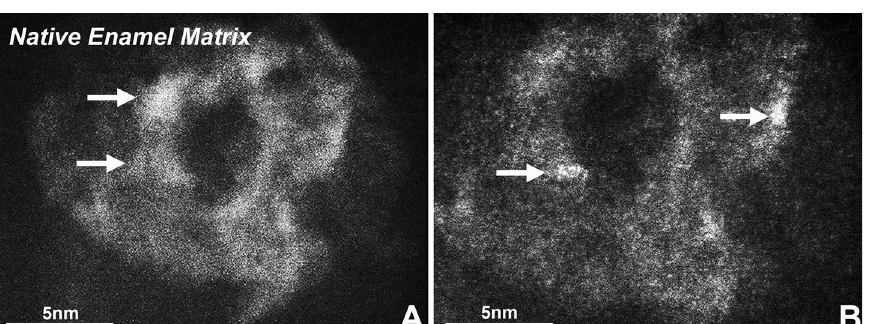
Fig. 2 Enamel matrix subunit compartments from native enamel matrix and in ameloblast secretory vesicles imaged using aberration-corrected scanning transmission electron microscopy (STEM) imaging. A and B are STEM images of different parts of the natural enamel of 1 day postnatal developing mouse molars. Crystal nucleation in the compartment of organic subunits in natural enamel matrix can be seen in both A and B . Note the individual 1 – 3 nm diameter nucleation sites (arrows, A , B ) randomly dispersed with a circular 20 nm diameter organic matrix assembly (matrix) ( A , B ).